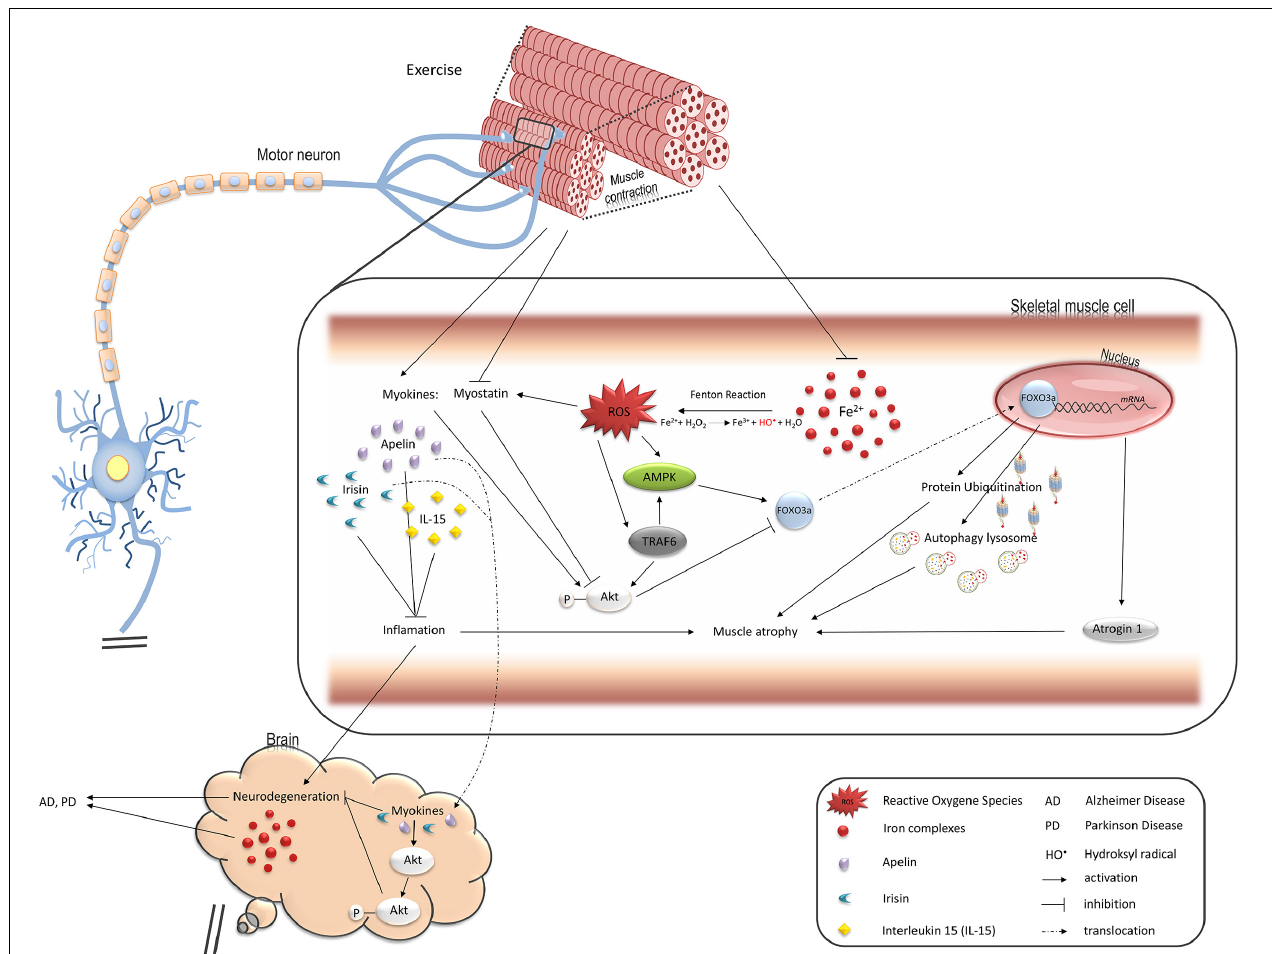
FIGURE 1 | Pathways regulated by oxidative stress induced by iron overload in muscle cells and leading to muscle atrophy, changes in endocrine functions, and contributing to neurodegeneration. FOXO3a transcription factor upregulates two main protein degradation pathways, ubiquitin-proteasome and autophagy-lysosome, both involved in muscle atrophy (see details in the text). Iron-mediated ROS elevation inhibits activity of FOXO3a negative regulator, Akt, and stimulates its positive regulator, AMPK. TRAF6 ubiquitin ligase is also involved in stimulation of muscle atrophy mediated by FOXO3a as well as inflammatory response and might be activated by ROS. Ferrous iron-induced ROS have been shown to activate TRAF6 in hepatic macrophages. ROS also induce production of myostatin which leads to muscle atrophy. On the other hand, exercise downregulates myostatin while such myokines as apelin or IL15 are increased and stimulate Akt in skeletal muscle and neuronal tissue thus protect against muscle and neurons atrophy. Loss of muscle mass thus, reduction in their endocrine functions may accelerate neurodegeneration and degeneration of motor neurons promotes muscle